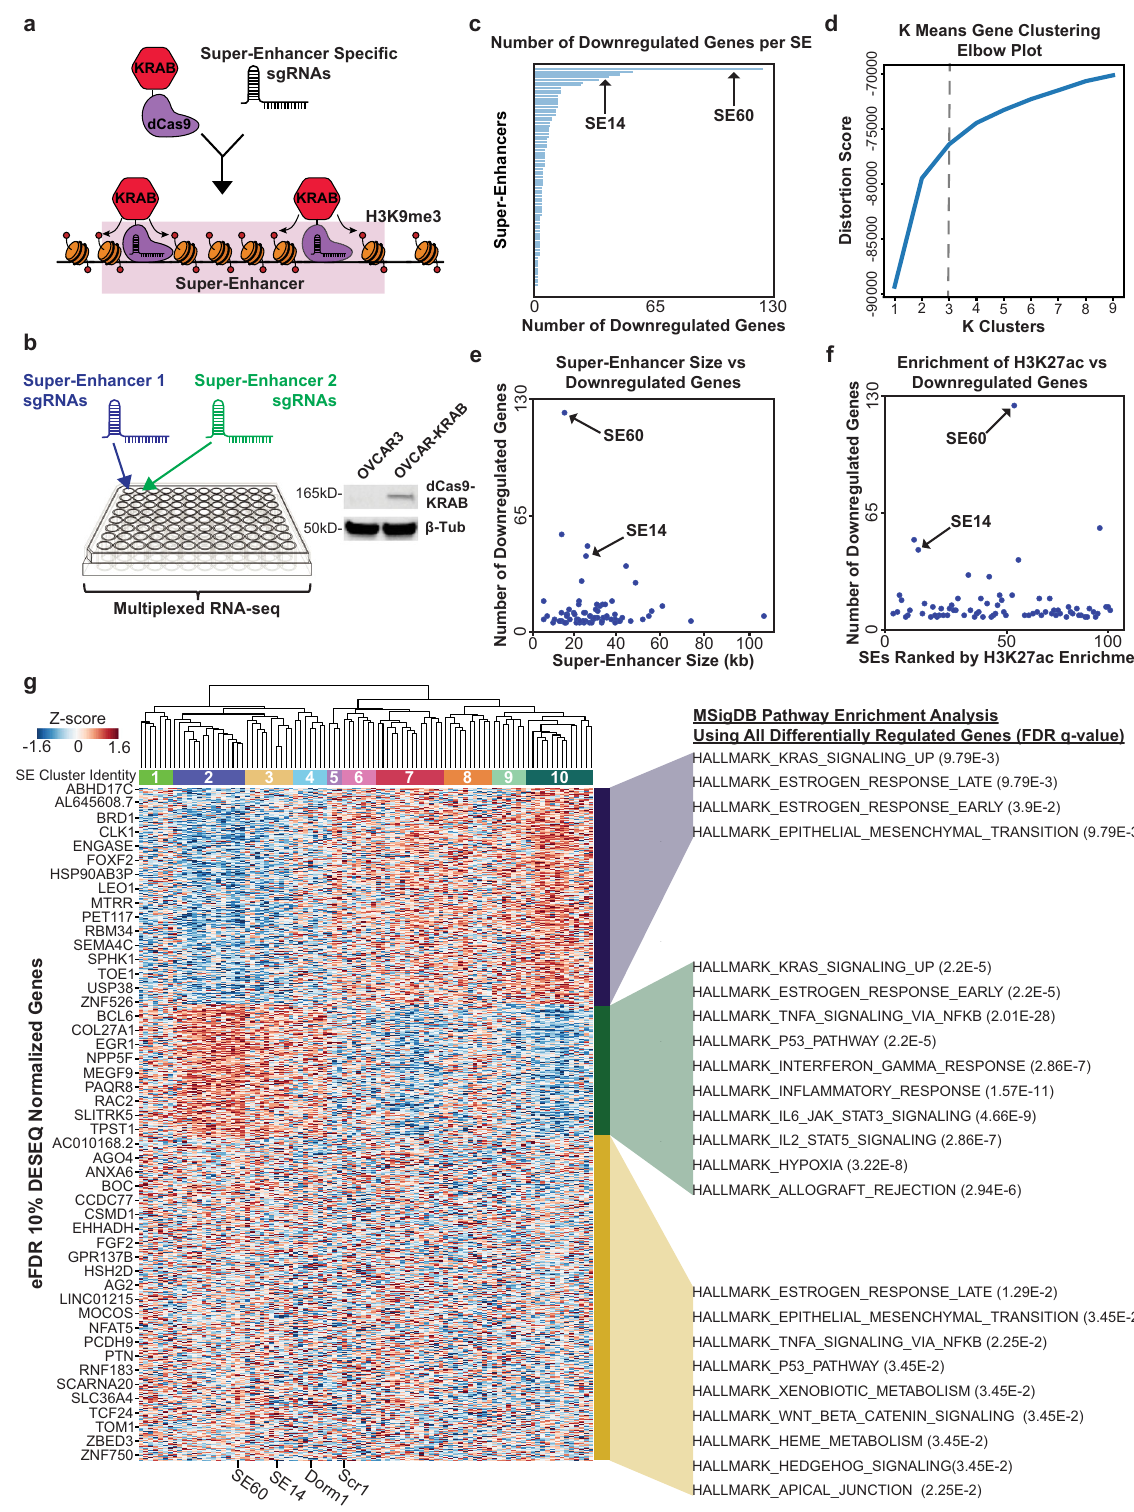
MSigDB Pathway Enrichment Analysis Using All Differentially Regulated Genes (FDR